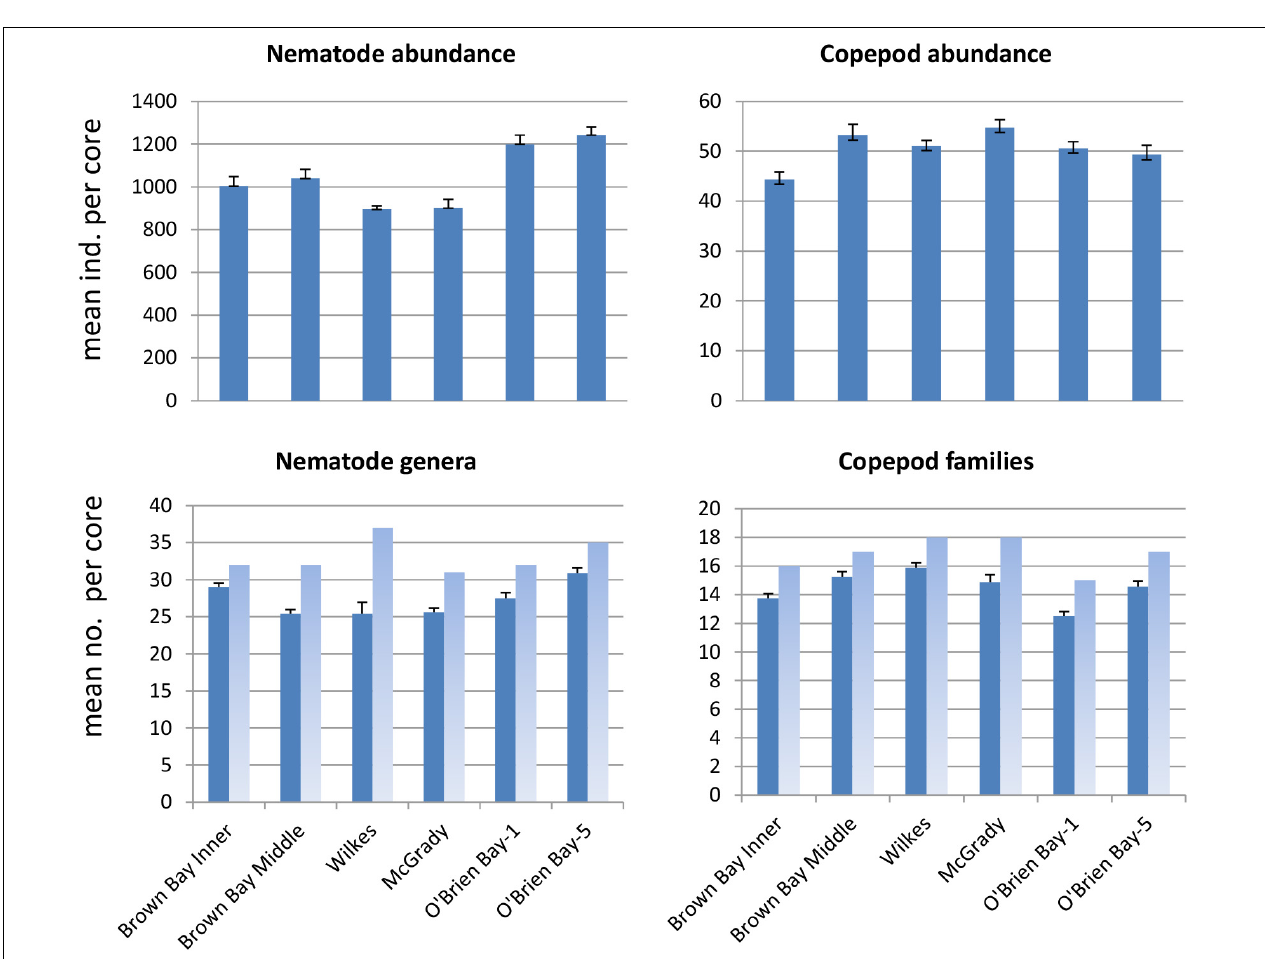
FIGURE 2 | Mean abundance and number of taxa per core at each location ( ± SE). Dark bars represent mean per core ( n = 8, except O’Brien Bay-5: n = 7); light bars represent total number of taxa found at each location.